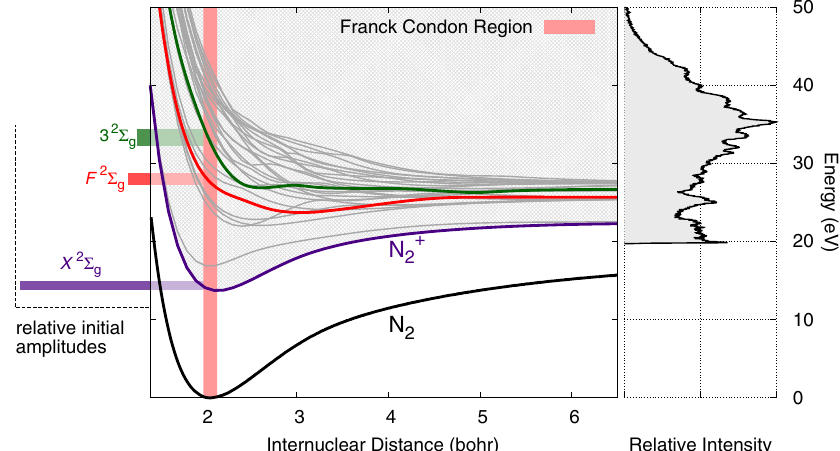
FIG. 1. Potential energy curves of the ground state of N 2 (black curve) and the relevant electronic states of N 2 þ (gray curves): the most relevant electronic states in the ionization process with Σ purple, red, and green lines, respectively. Left: Relative initial populations of the X 2 Σ XUV